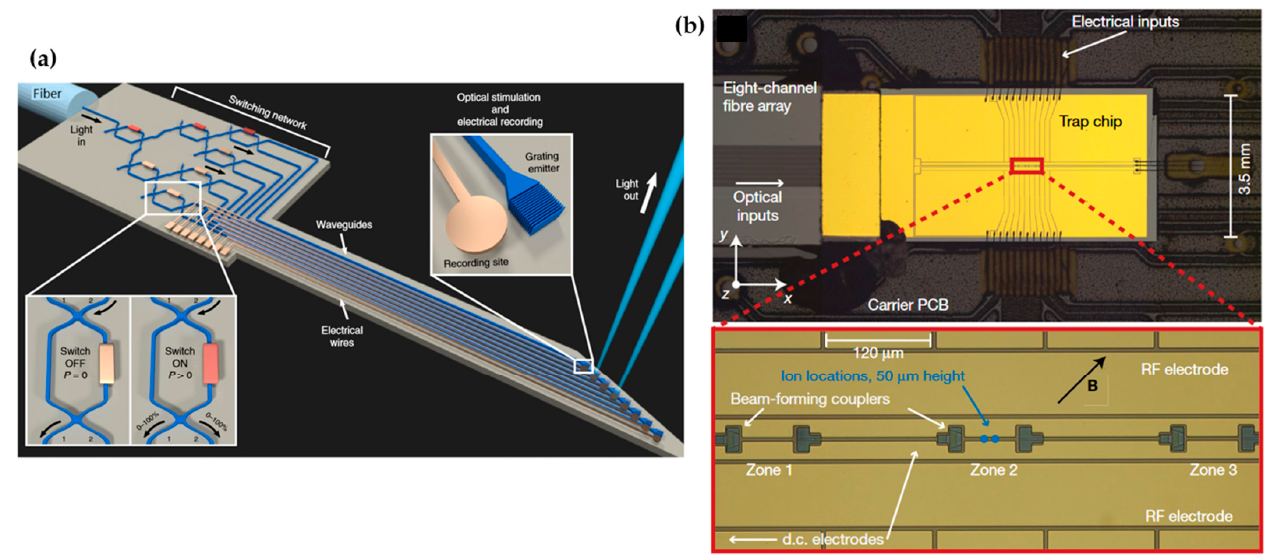
Figure 13. ( a ) Schematic of an optogenetics probe based on the SiN platform. Reprinted by permission from Springer Nature: Nature Biomedical Engineering [17] © Springer Nature (2020). ( b ) Optical micrograph of a photonic circuit integrated with a surface-electrode ion trap to obtain quantum logic gates. Reprinted by permission from Springer Nature: Nature [95] © Springer Nature (2020).